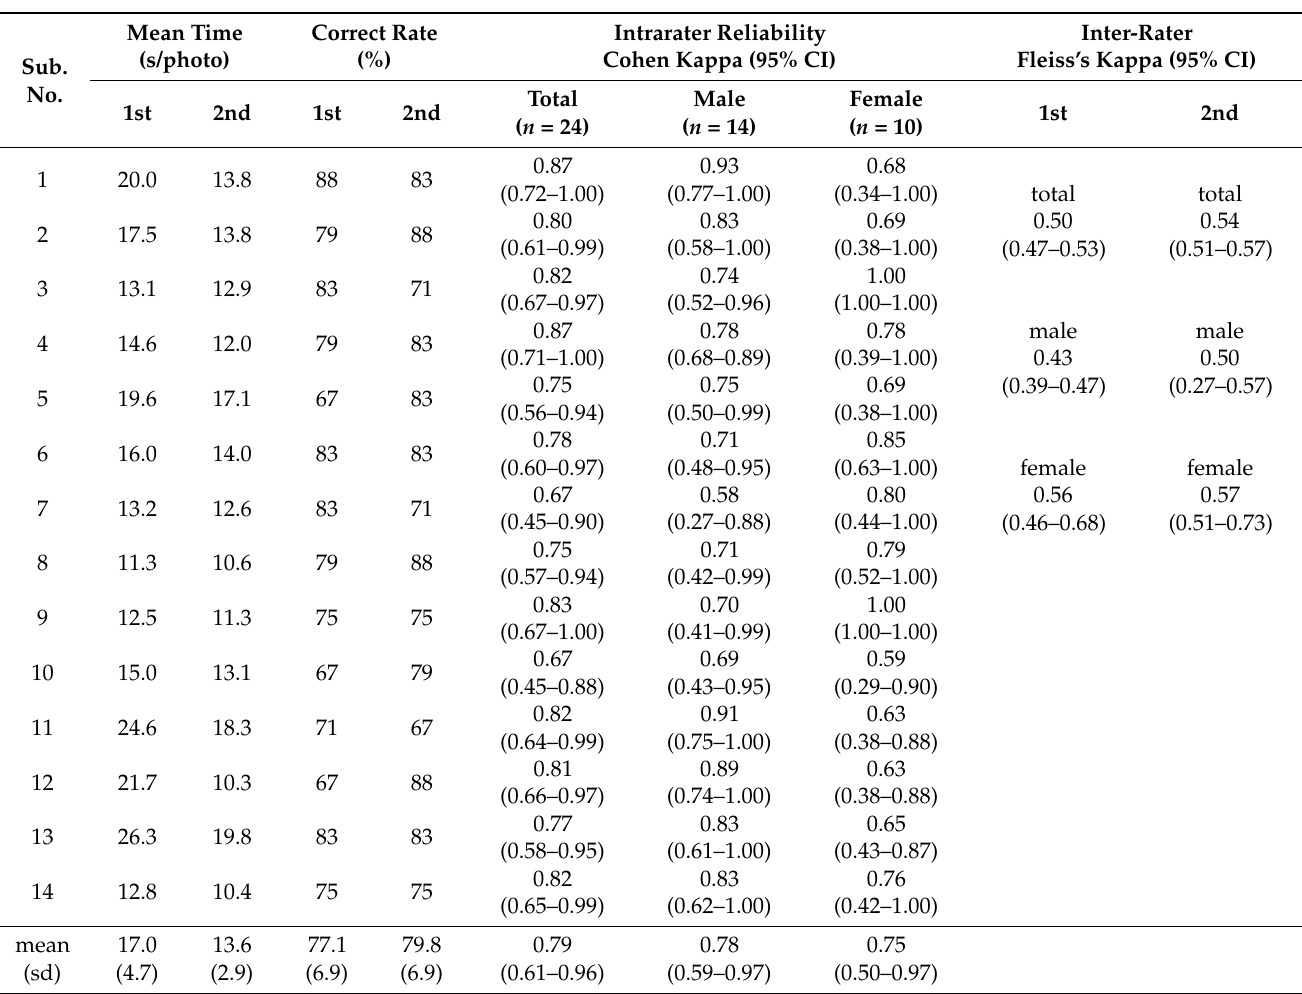
Table 2. Results of usability metrics and intra-/inter-rater reliability of the PI classification tool using the HKL